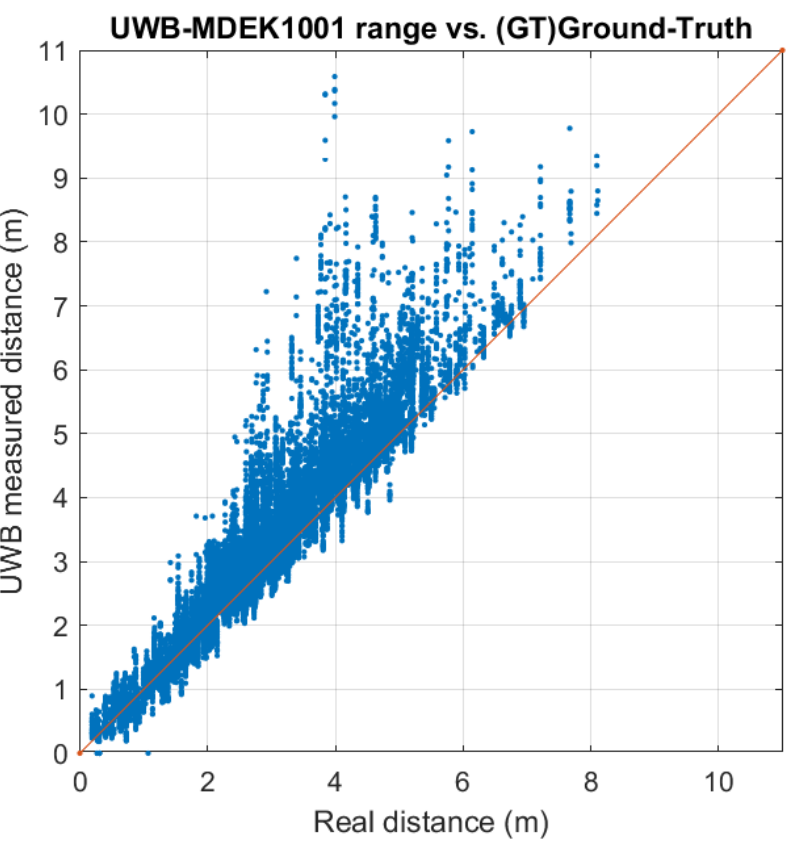
Figure 19. Real-distance vs. UWB measured distance (tag to anchors) at the apartment scenario.